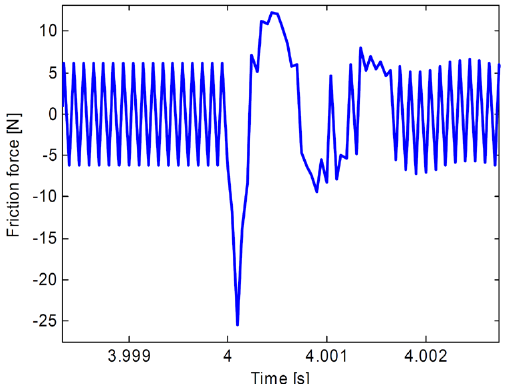
Figure 12. Friction force predicted using Stribeck model (at around the 4th second).